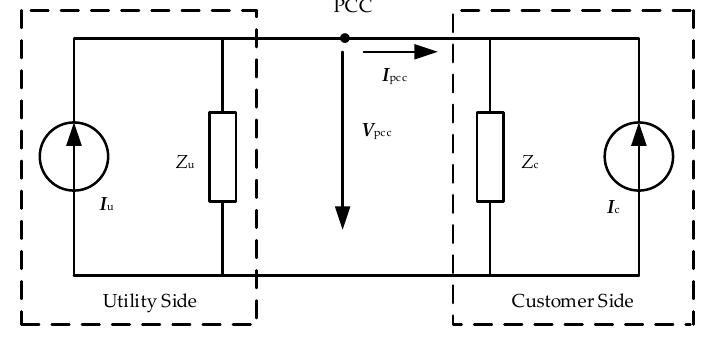
Figure 2. Norton equivalent circuit.